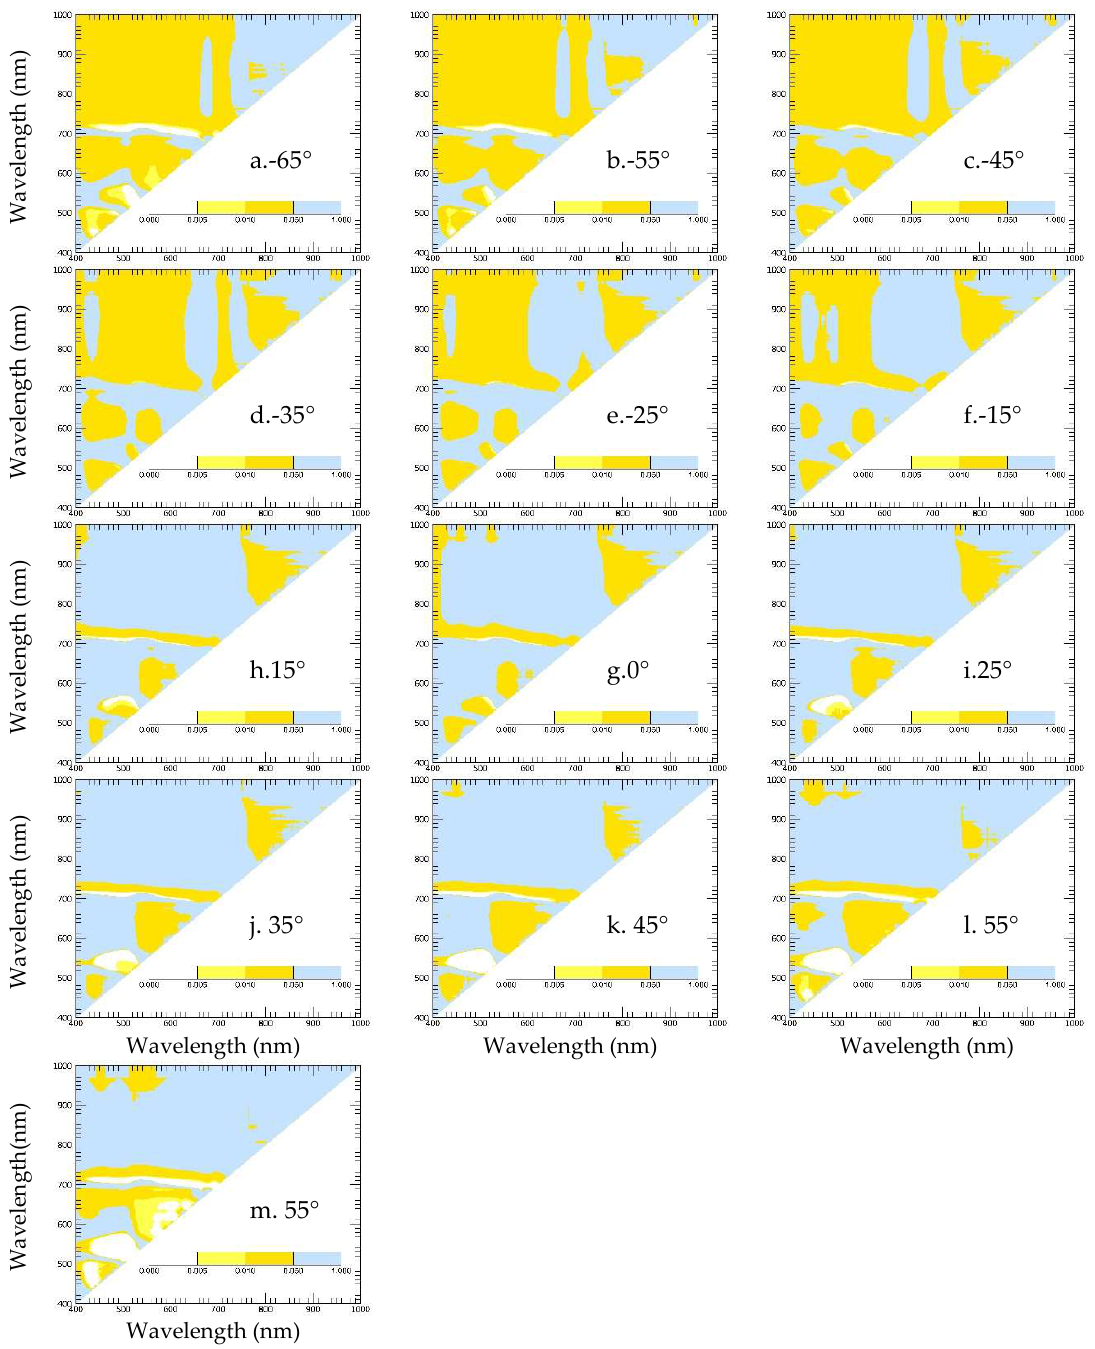
Figure A2. Contour maps of significance levels (P-values) of the linear correlations between NDSI(x,y) and the ground measured LAI for thirteen VZAs in PP for the erectophile variety based on in-situ measurements. Subtitle a.-m. shown in each graph denotes observation angle.